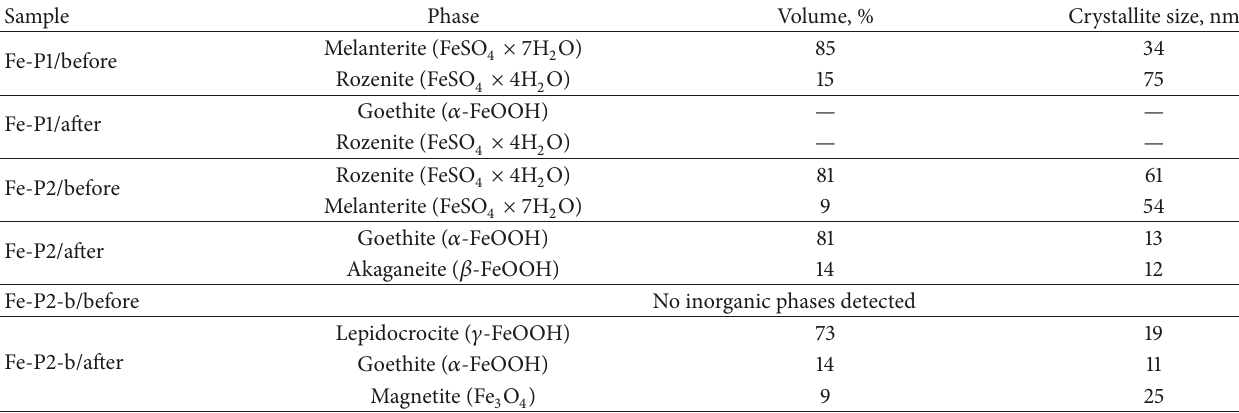
Figure 3: X-ray diffraction patterns of the samples Fe-P1 (1), Fe-P2 (2), and Fe-P2d (3) taken prior to (a) and after (b) corrosion experiments. Table 1: Composition (in volume%) and structural parameters ofinorganic layers at the PANI-Fe interface before and after corrosion experiment.